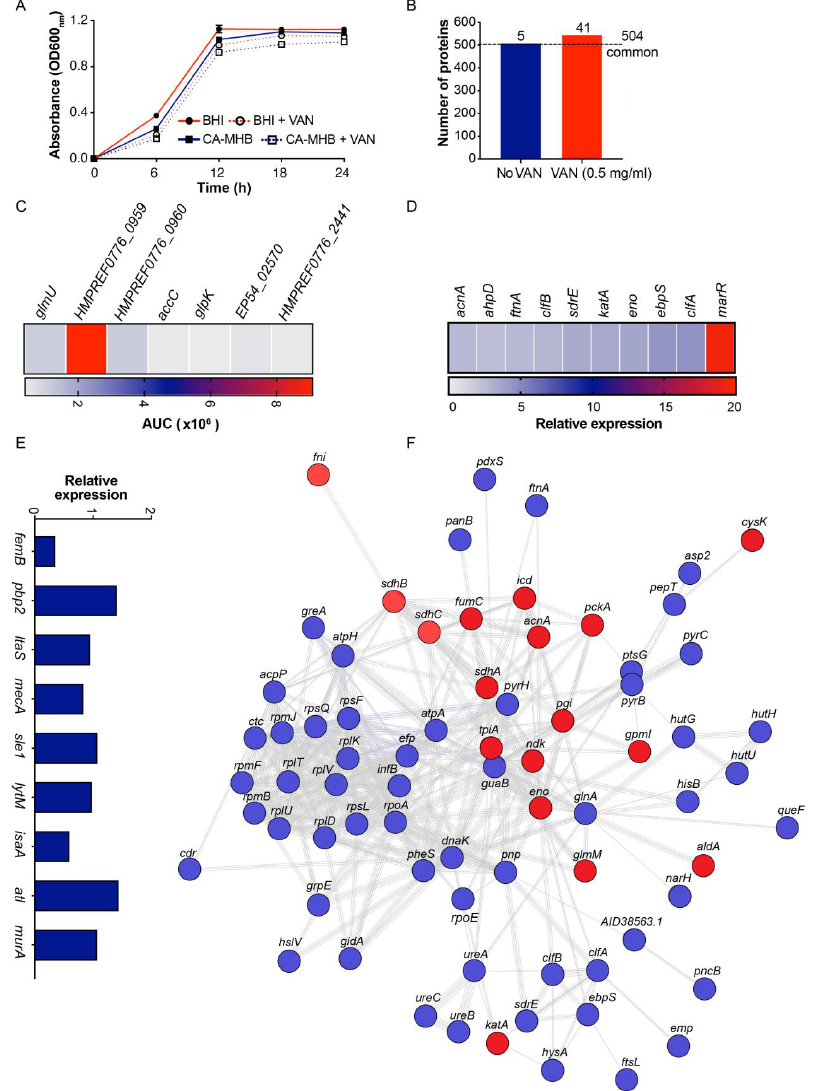
Figure 3. Proteomic profile of MV peptides derived from VAN pre-treated MRSA. ( A ) Growth of MRSA in BHI or CA-MHB +/− VAN (0.5 mg/L) at 24 h was not impeded by the presence of sub-MIC VAN. ( B ) Number of proteins identified from MVs isolated from untreated or VAN pre-treated MRSA. Heat maps illustrating unique MV proteins associated with ( C ) cell wall or cell membrane metabolism and ( D ) virulence from MRSA pre-treated with VAN are represented as the area under the curve (AUC) or relative expression (>2-fold expression relative to proteins identified from untreated MRSA-derived MVs), respectively. ( E ) Expression of proteins involved in cell wall biosynthesis (e.g., peptidoglycan and lipoteichoic acid) from MV proteins derived from VAN pre-treated MRSA relative to untreated MRSA. ( F ) Functional STRING and KEGG analyses of proteins expressed under selective pressure from sub-MIC VAN demonstrated a highly interconnected network of proteins associated with general metabolic processes (gray), virulence (blue) and antibiotic resistance (red). Singletons or chains with no interaction within the main network have been deleted. Gene nomenclatures are depicted in Supplementary Dataset 1 and 2. MVs: Membrane Vesicles; BHI: Brain Heart Infusion; CA-MHB: Cation-adjusted Mueller–Hinton Broth; VAN: Vancomycin; HMPREF0776_0959: Acetyl- CoA C-acetyltransferase; HMPREF0776_0960: 3-hydroxyacyl-CoA Dehydrogenase; EP54_02570: Lipoprotein; HMPREF0776_244: Peptidase (S41 Family).